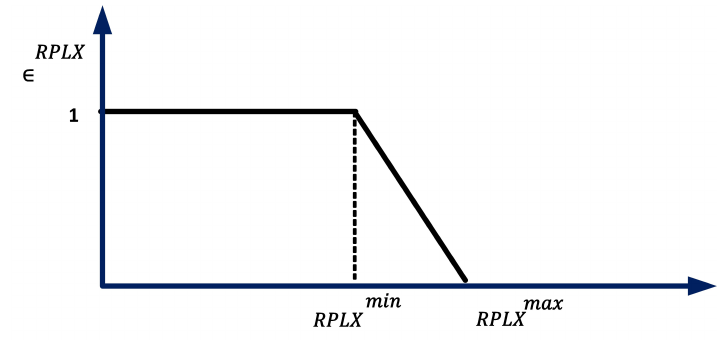
Figure 2. Reduction of real power loss.